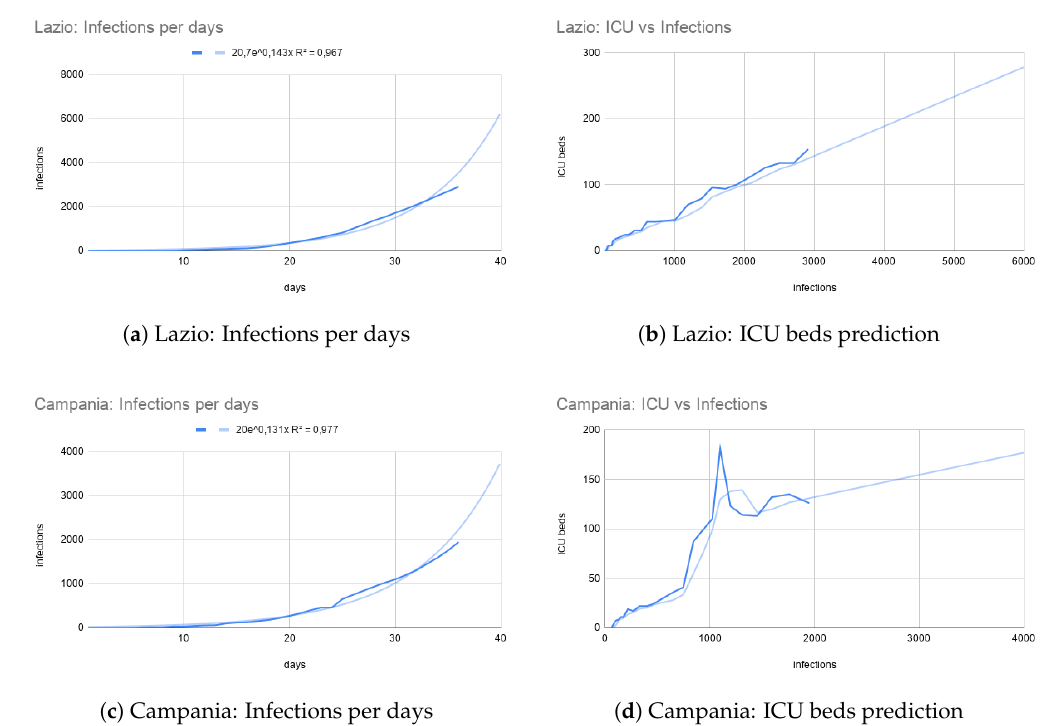
Figure 6. Infections per days (with exponential fitting) and ICU bed vs. Infection (with moving average of modulus 3) graphs for the Lazio and Campania southern regions at the date of 30